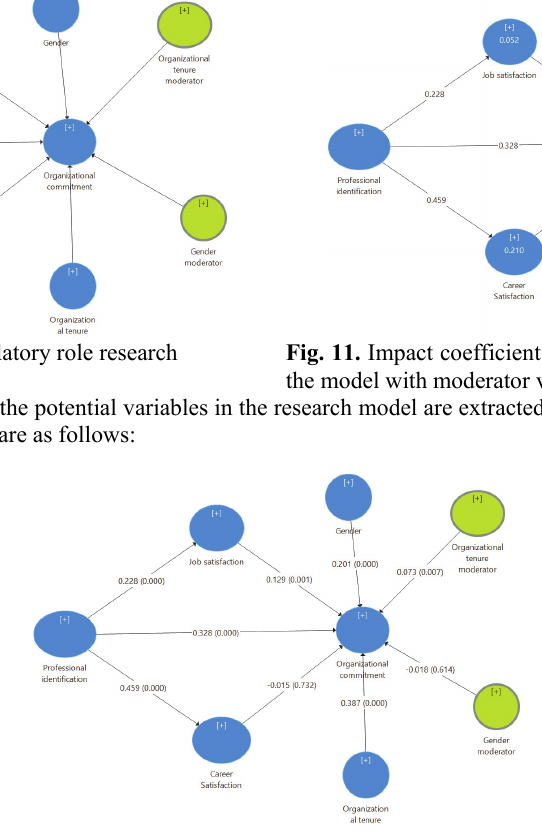
Original Sample Standard Sample (O) Mean (M) Deviation (STDEV)